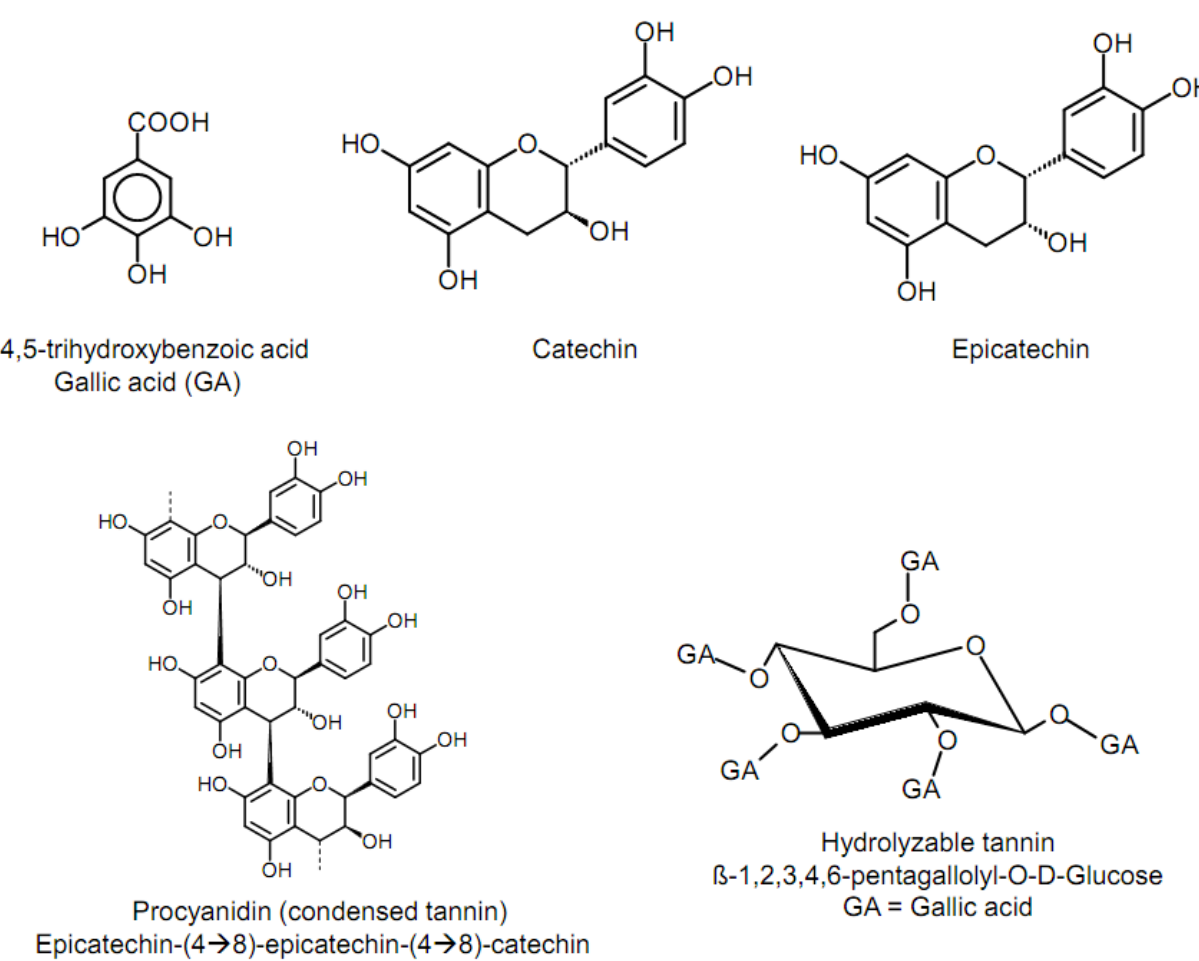
Figure 1. Typical Structures of hydrolyzable and condensed